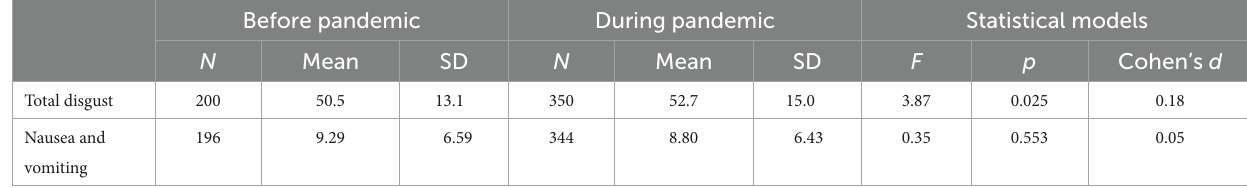
TABLE 3 Disgust sensitivity (DS-R) and nausea and vomiting (INVR) in pregnant women before and during the COVID-19 pandemic. Before pandemic During